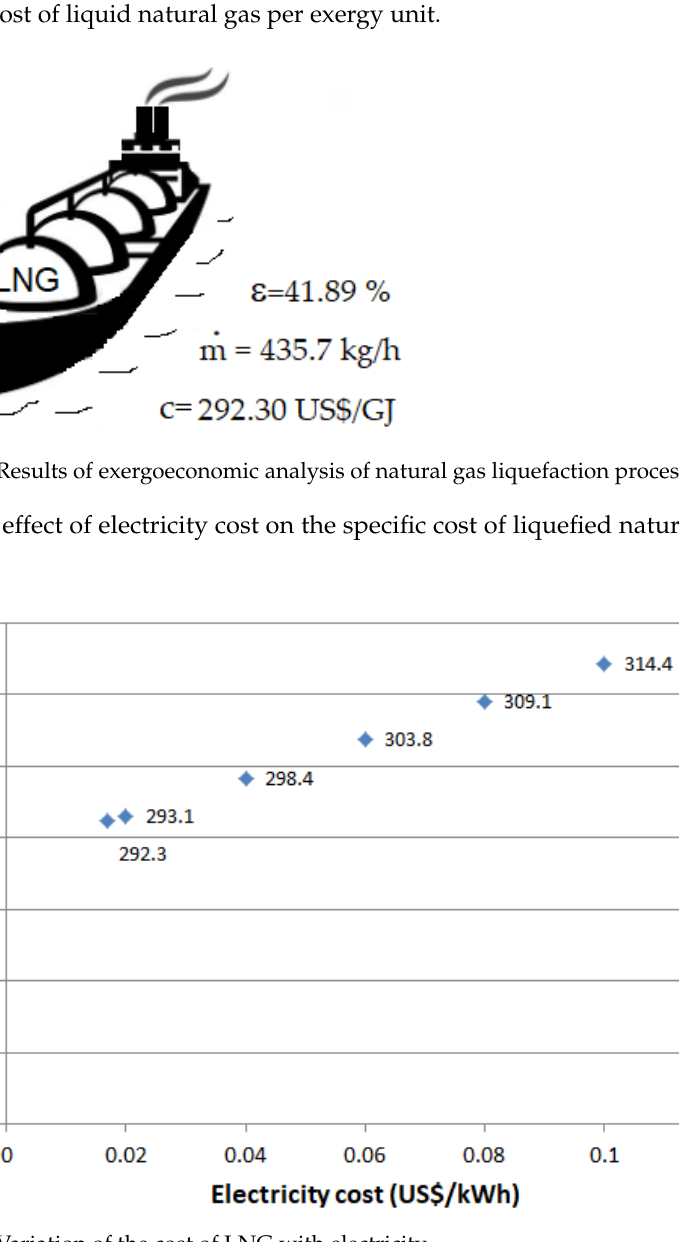
Figure 3. Variation of the cost of LNG with electricity.